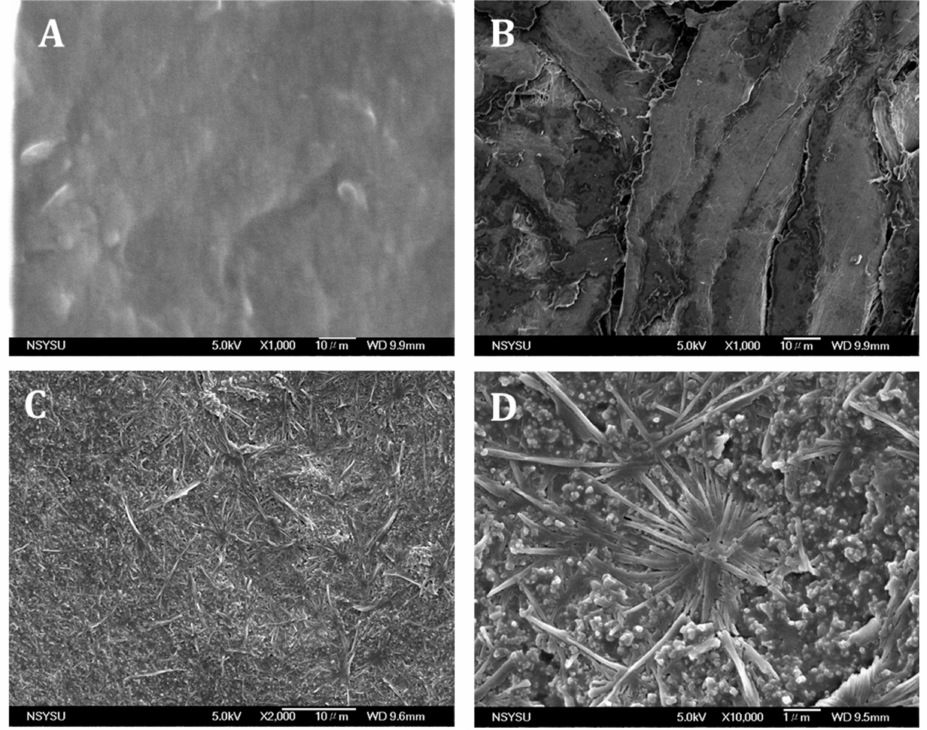
Figure 1. SEM images of ( A ) pencil graphite rod, ( B ) Pre-anodized pencil graphite rod, ( C , D ) Poly(thionine) on the pre-anodized pencil graphite rod with different